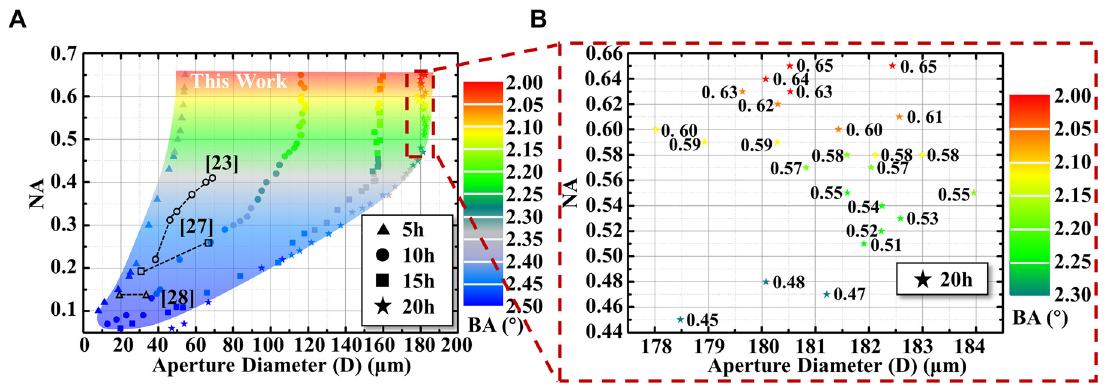
Figure 3: The aperture diameters and NAs of microlenses fabricated using the proposed technology at different etching time. (A)RelationshipbetweenaperturediametersandNAsofthemicrolensesfabricatedbytheBAsofthedifferentBLBsanddifferentetchingtime. And the apertureand NAs of the microlensin other reports.(B)Relationshipbetween the aperture diametersfrom 178to 184 μ m in(A) and the NAs of the microlenses de fi ned by the BAs of the different pulses was 0.12 – 0.28 (Figure S4). The LCSM images of the etched microlenses by varying the number of Gaussian laser pulsesfrom1to1000,andtherelationshipamongthenumber of pulses, aperture diameters, and heights are shown in Figure S5. After calculation, the range of NAs adjustable by